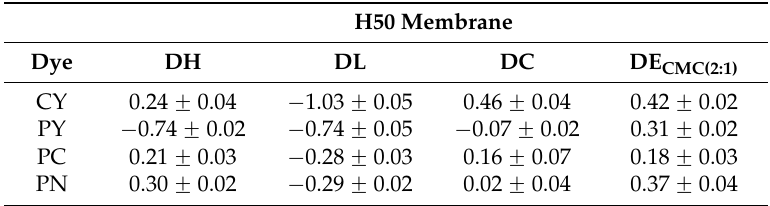
Table 3. Colour differences values for the H50 membrane.